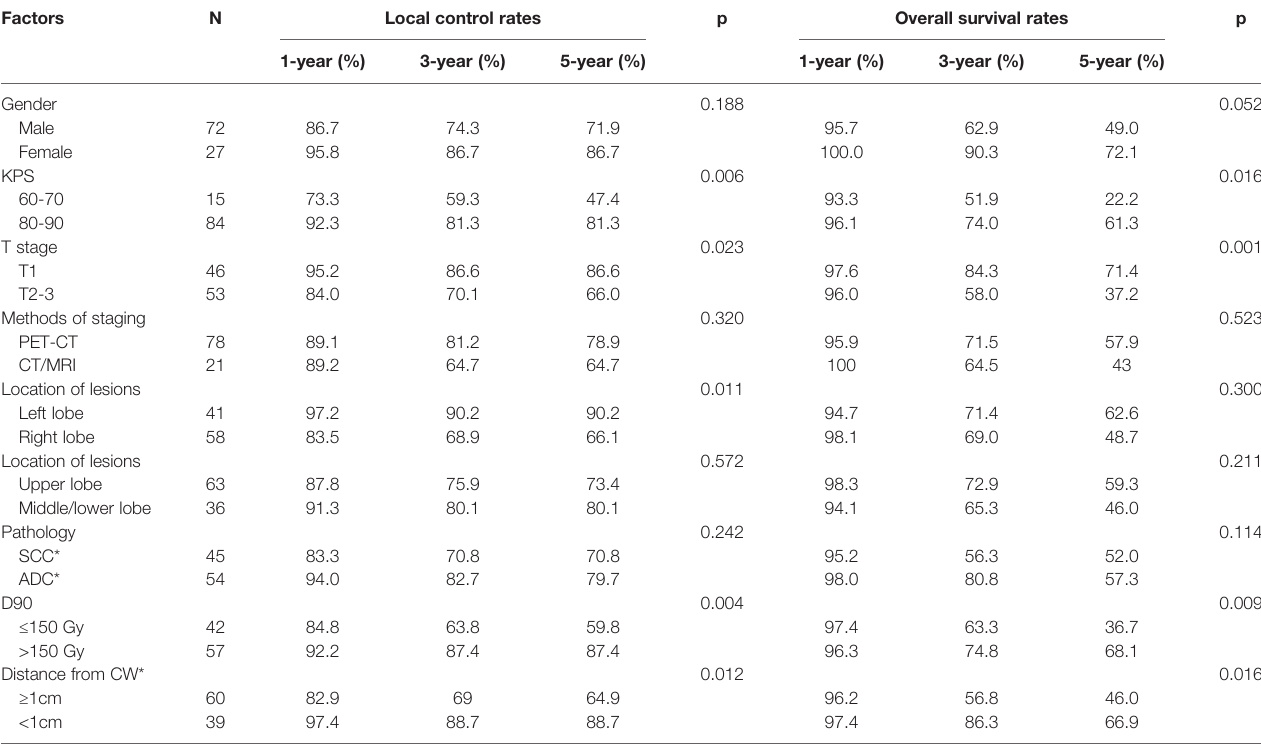
TABLE 2 | Univariate analysis of factors associated with local control and survival. Factors N Local control rates